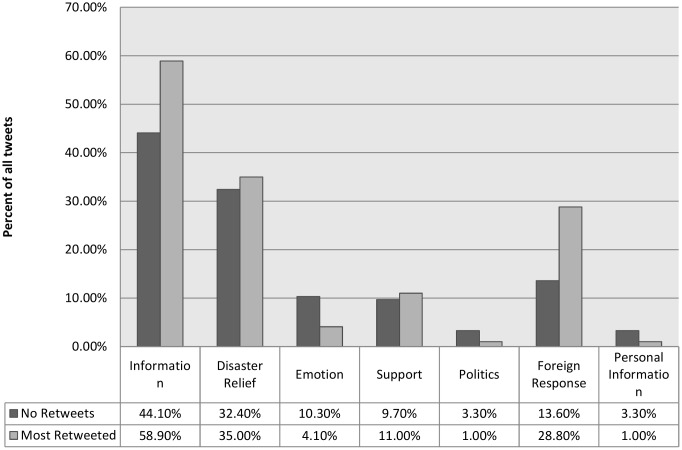
Content of tweets.